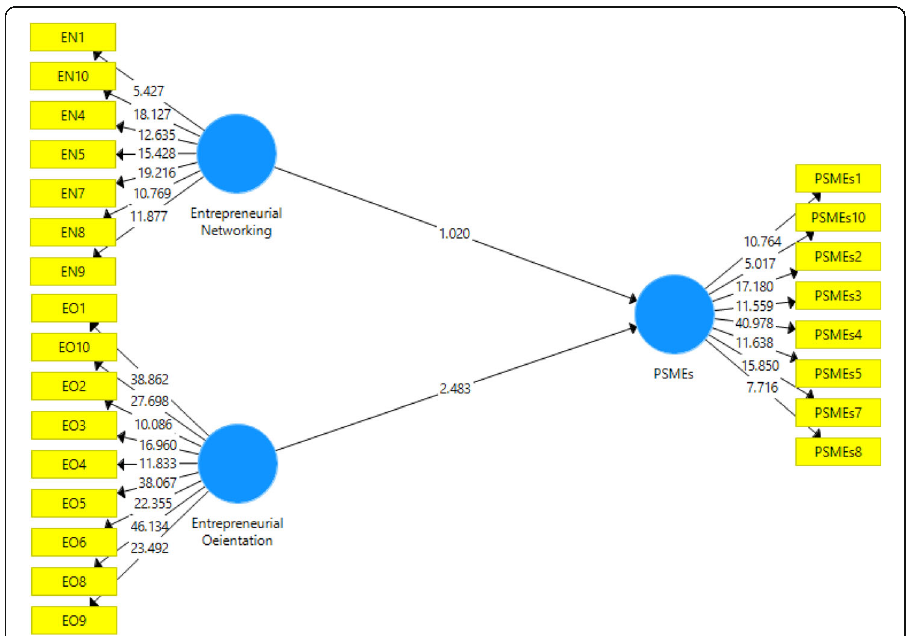
Fig. 2 Direct Relationships